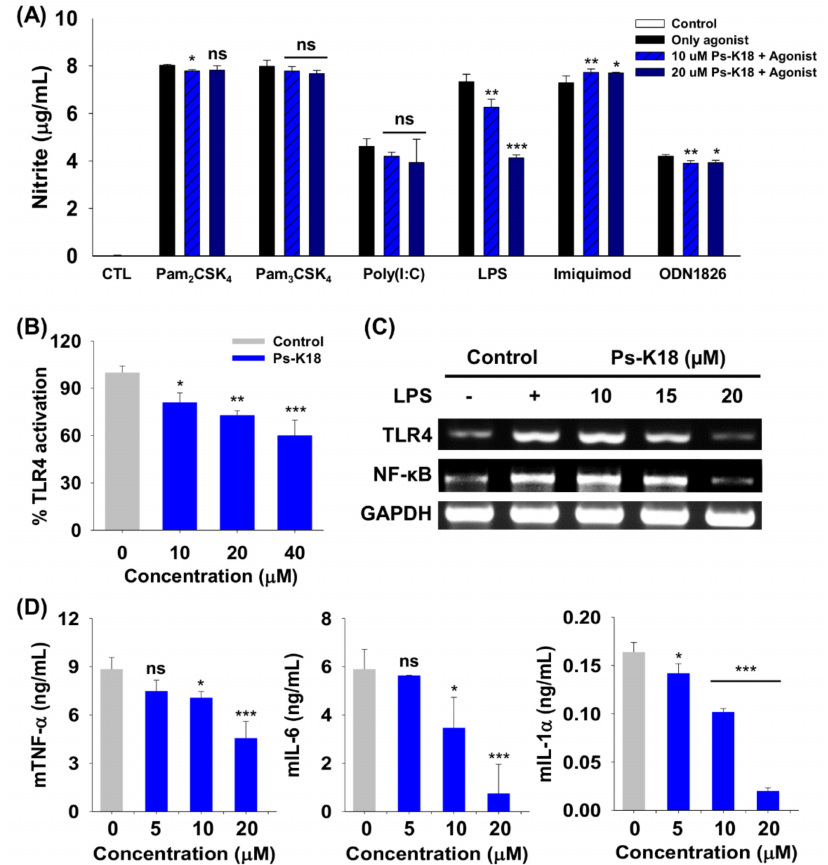
Figure 4. Specificity of Ps-K18 toward various Toll-like receptors (TLRs) and TLR-specific agonists, and anti-inflammatory activity of Ps-K18. ( A ) Specificity of Ps-K18 for TLRs and TLR-specific agonists that selectively activate TLRs, as determined by measuring nitrite production in RAW264.7 cells. Di ff erent TLRs were selectively activated by Pam 2 CSK 4 (200 ng / mL), Pam 3 CSK 4 (200 ng / mL), Poly(I:C) (2 µ g / mL), LPS (20 ng / mL), imiquimod (1 µ g / mL), and ODN1826 (20 µ g / mL). Control is the data without agonist treatment. ( B ) Dose-dependent reduction in secreted alkaline phosphatase reporter gene (SEAP) activity by Ps-K18 in LPS (20ng / mL)-stimulated HEK-Blue ™ hTLR4 cells. ( C ) Inhibitory e ff ect of Ps-K18 on inflammation-related gene expression in LPS (50 ng / mL)-stimulated RAW264.7 cells. The cells were pre-treated with Ps analogues for 1 h and then treated with LPS for 12 h. ( D ) Inhibitory e ff ects on the production of inflammatory cytokines tumor necrosis factor- α (TNF- α ), interleukin (IL)-6, and IL-1 α by Ps-K18 (5 µ M, 10 µ M, and 20 µ M) in LPS (20 ng / mL)-stimulated RAW264.7 cells. The error bars represent means ± standard error of the mean (* p < 0.05; ** p < 0.01; *** p < 0.001; ns. represents no